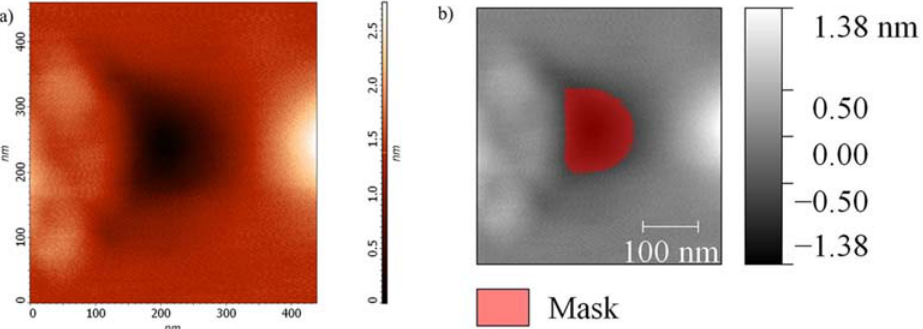
Figure 5. Semi-contact AFM image of an indent on Sample #1 surface ( a ); same image as in the upper panel after cropping and analysis with the software Gwyddion ( b ).